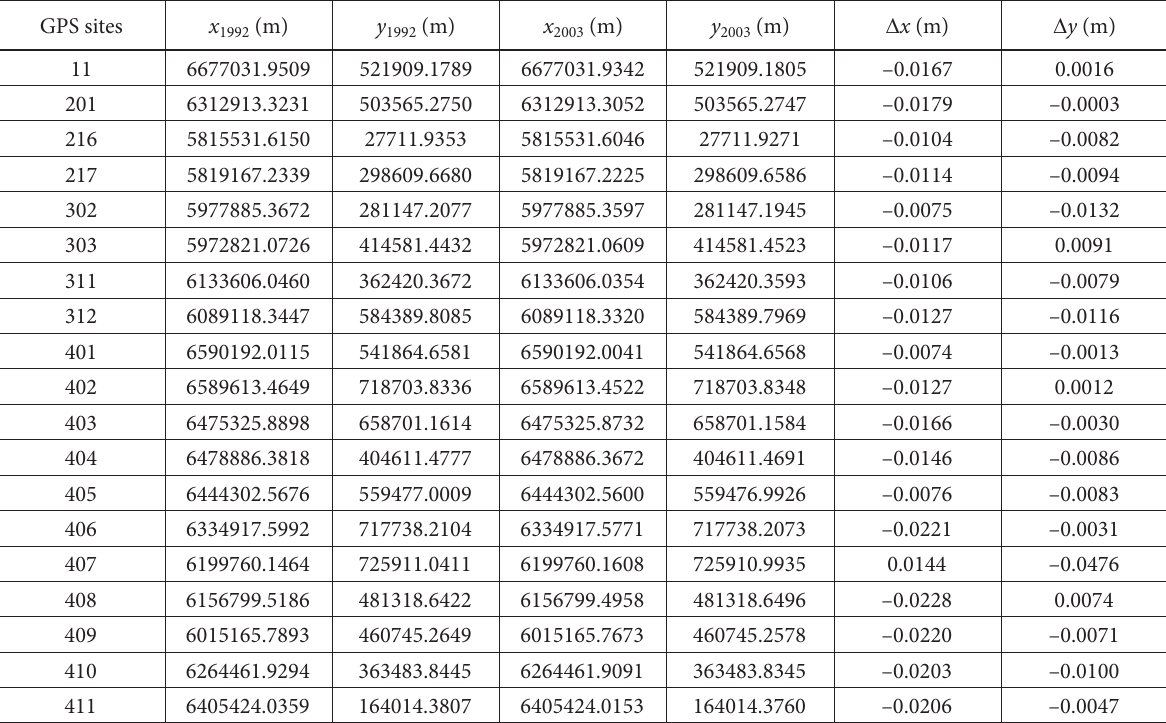
Table 1. Plane rectangular coordinates of GPS sites and their changes GPS